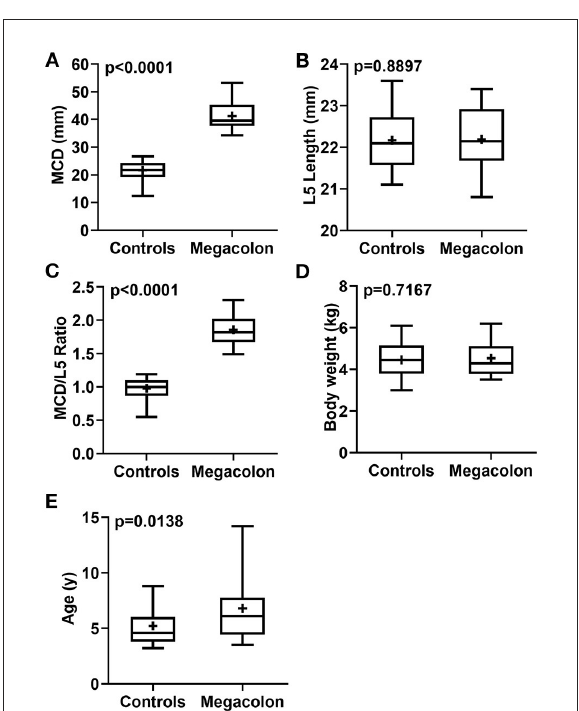
FIGURE3 Box-and-whiskers plots of MCD (A) , L5L (B) , MCD/L5L ratio (C) , body weight (D) , and age (E) for cats that had confirmed idiopathic megacolon ( n = 30) or healthy without evidence of either gastrointestinal or vertebral column diseases (controls; n = 30). The line represents the median, the cross represents the mean, and the whiskers rep-resents the range. Significant at p < 0.0001 and p <